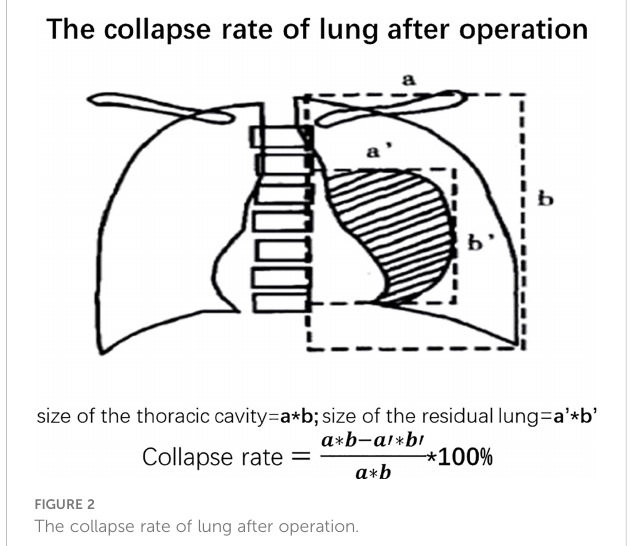
FIGURE 2 The collapse rate of lung after operation.